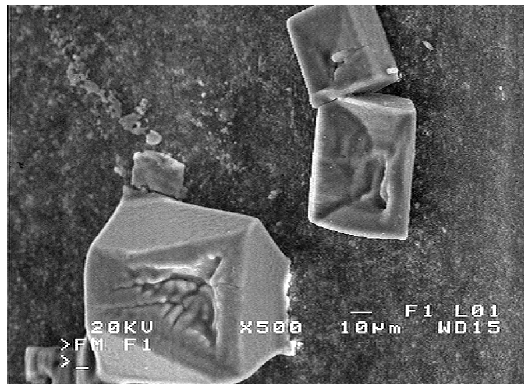
Figure 12. SEM images of salt crystals formed on the distillate side during membrane drying.